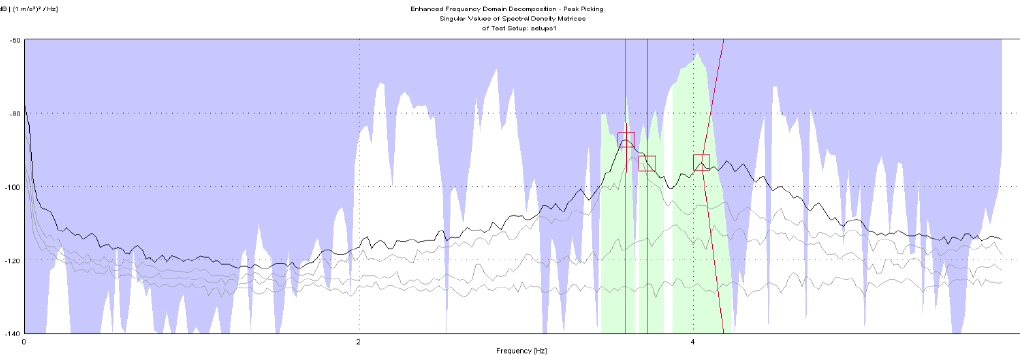
Figure 15. OMA identification with EFDD method, Test 3.